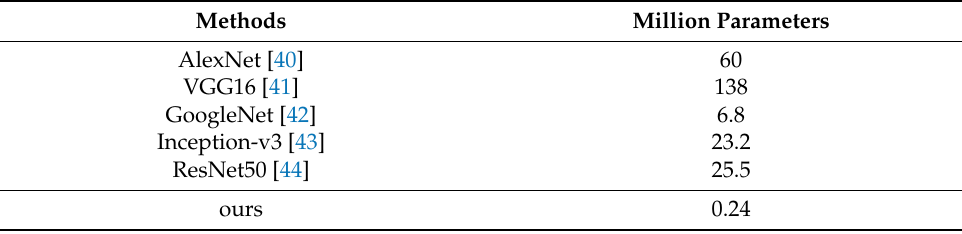
Table 3. Several classic convolutional neural network model parameters.